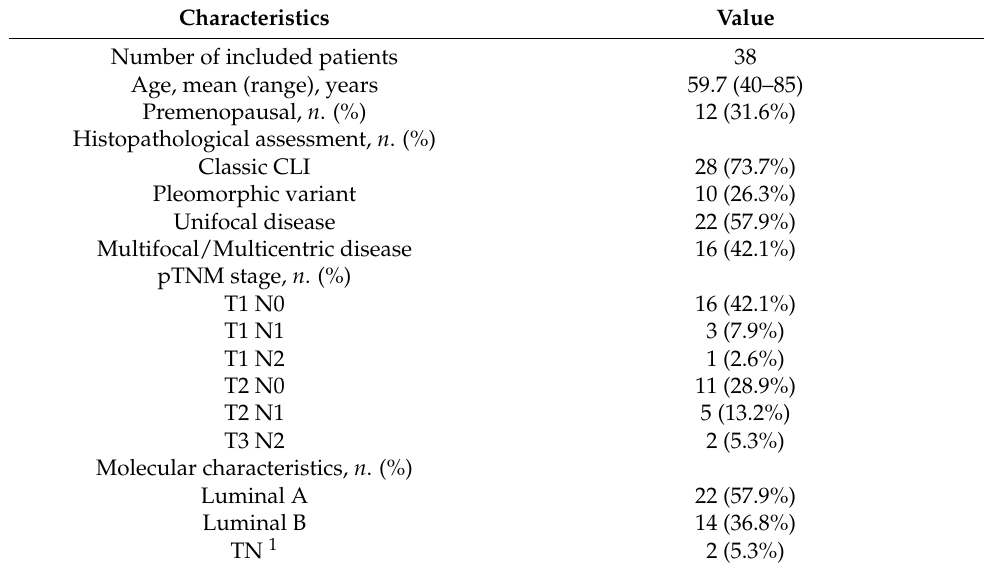
Table 1. Characteristics of patients.